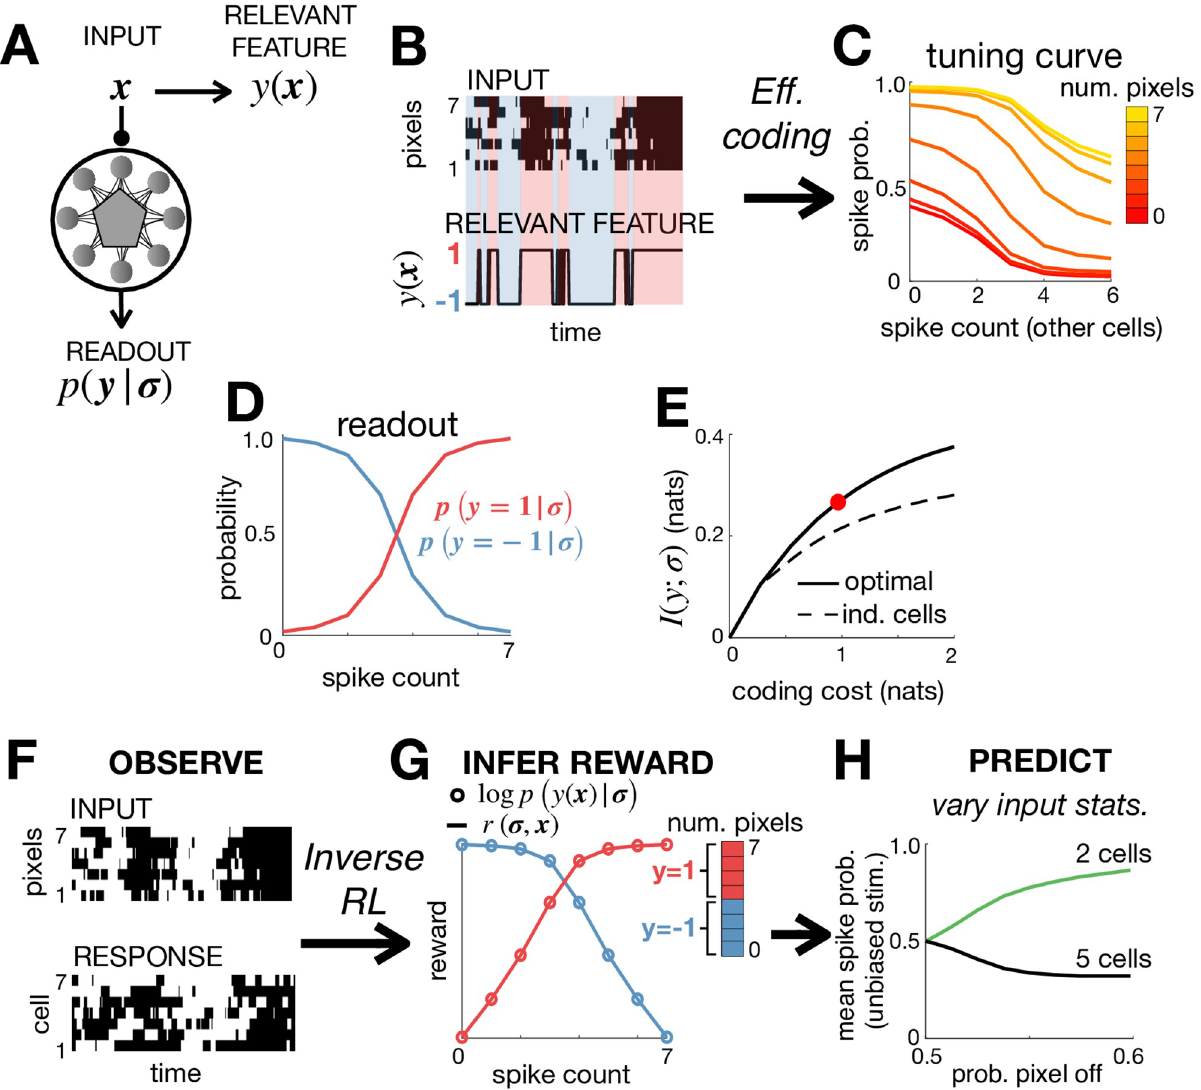
Fig 4. Efficient coding and inverse RL. ( A ) The neural code was optimised to efficiently encode an external input, x , so as to maximise information about a relevant stimulus feature y ( x ). ( B ) The input, x consisted of 7 binary pixels. The relevant feature, y ( x ), was equal to 1 if > 3 pixels were active, and -1 otherwise. ( C ) Optimising a network of 7 neurons to efficiently encode y ( x ) resulted in all neurons having identical tuning curves, which depended on the number of active pixels and total spike count. ( D ) The posterior probability that y = 1 varied monotonically with the spike count. ( E ) The optimised network encoded significantly more information about y ( x ) than a network of independent neurons with matching stimulus-dependent spiking probabilities, p ( σ i = 1| x ). The coding cost used for the simulations in the other panels is indicated by a red circle. ( F - G ) We use the observed responses of the network ( F ) to infer the reward function optimised by the network, r ( σ , x ) ( G ). If the network efficiently encodes a relevant feature, y ( x ), then the inferred reward (solid lines) should be proportional to the log-posterior, log p ( y ( x )| σ )(empty circles). This allows us to (i) recover y ( x ) from observed neural responses, (ii) test whether this feature is encoded efficiently by the network. ( H ) We can use the inferred objective to predict how varying the input statistics, by reducing the probability that pixels are active, causes the population to split into two cell types, with different tuning curves and mean firing rates